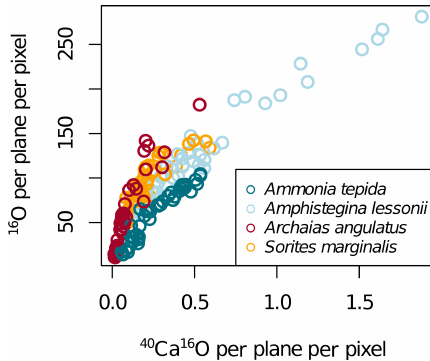
Figure A2. NanoSIMS 40 Ca 16 O per plane per pixel and 16 O per plane per pixel in four foraminifera species. The NanoSIMS ion count rates of 40 Ca 16 O and 16 O highly correlated in calcite (Fig. A2), which is why elemental ratios can be normalized to both for display. As elemental ratios determined in bulk calcite are normalized to calcium, we present the NanoSIMS data mostly as El / 40 Ca 16 O ion count ratios.